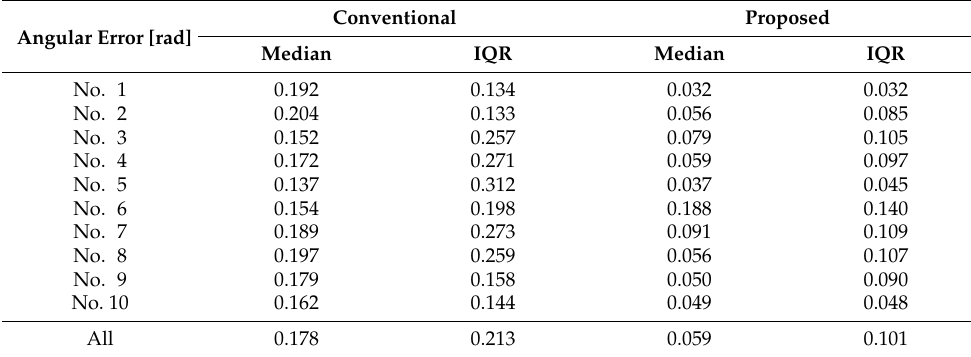
Table 5. Median and interquartile range (IQR) of the heading direction (angular) error—square pattern. Conventional Proposed Angular Error [rad]